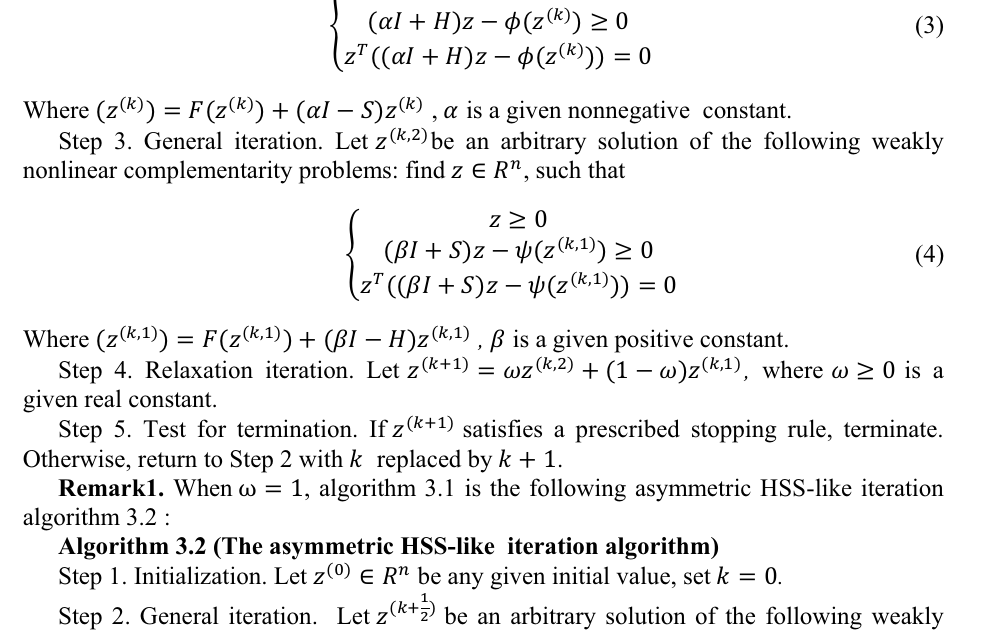
Algorithm 3.2 (The asymmetric HSS-like iteration